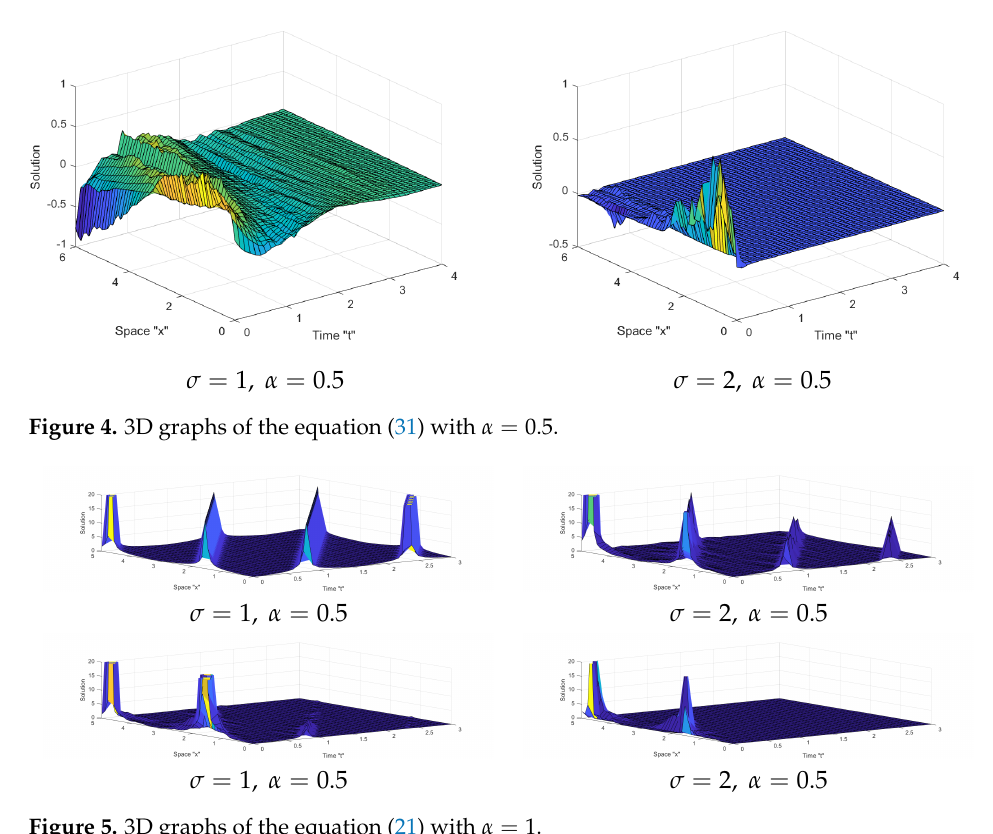
Figure 5. 3D graphs of the equation (21) with α = 1.